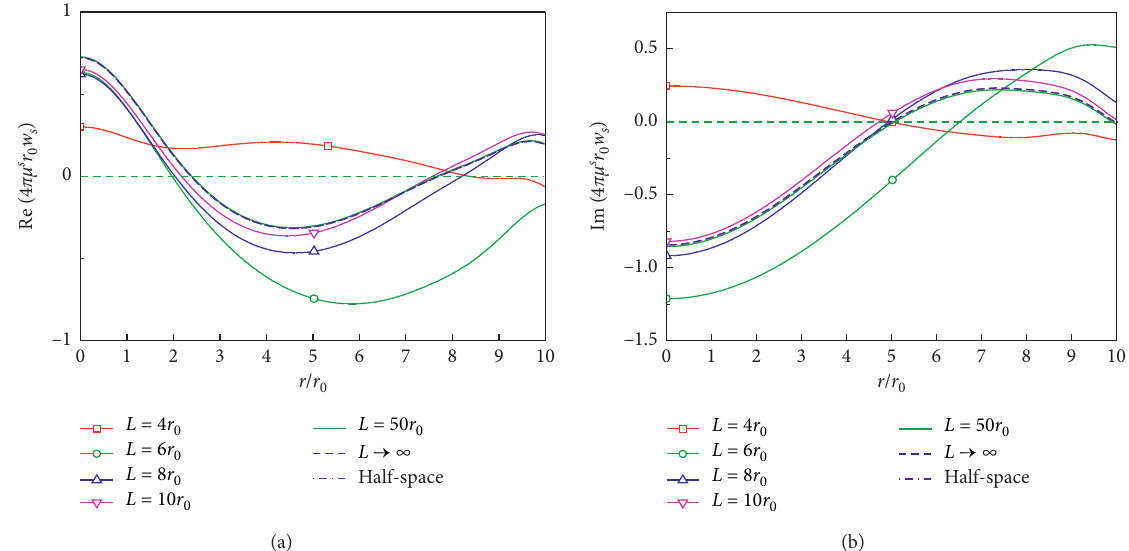
Figure 9: Vertical displacement w displacement; (b) imaginary part of vertical displacement.